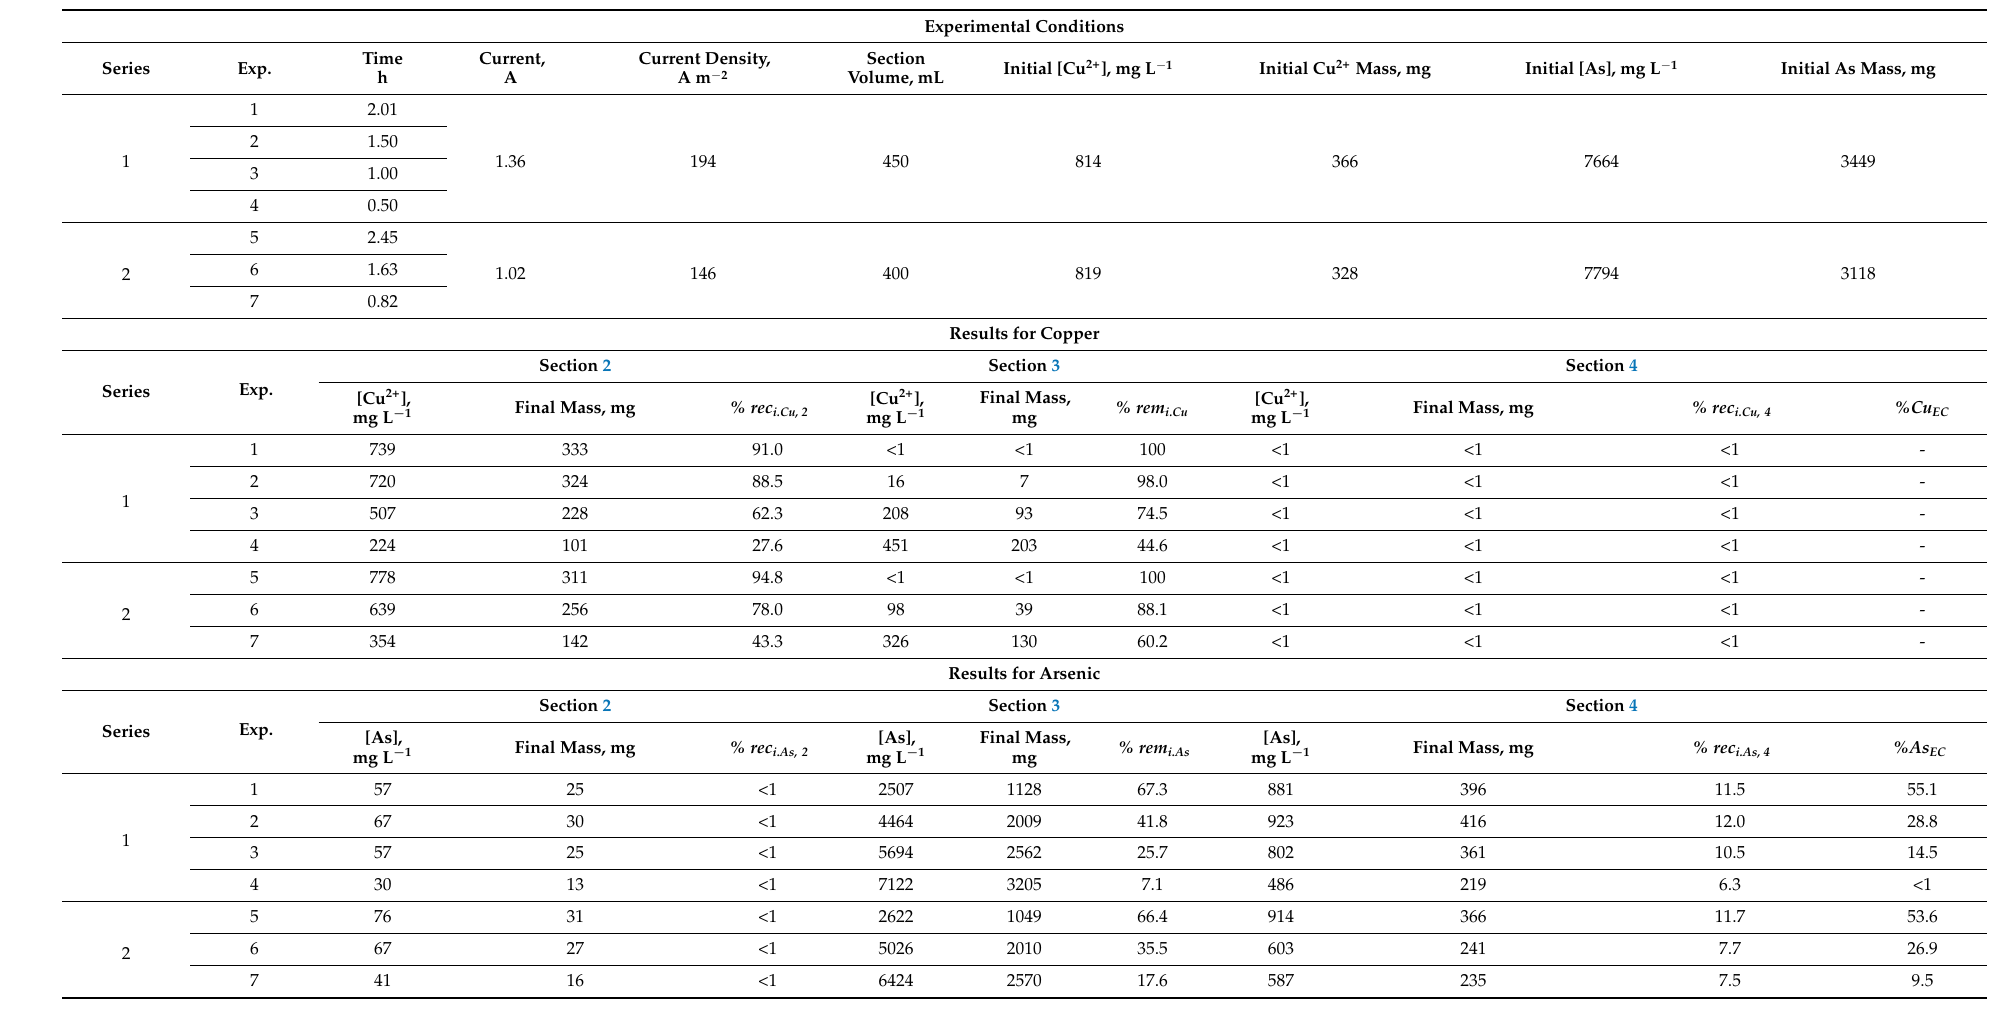
Table 1. Experimental conditions and